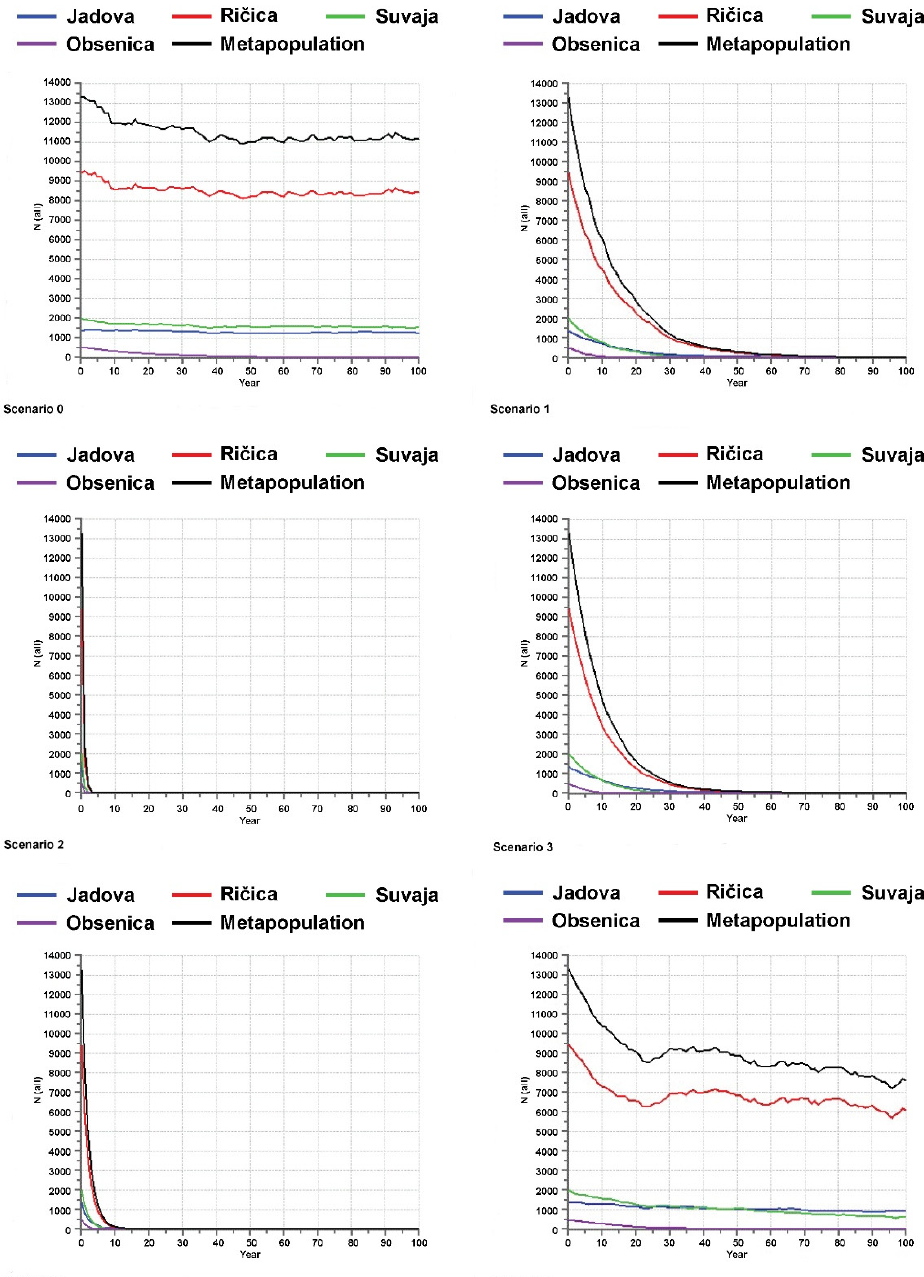
Figure 2. Results of population viability analyses for T. croaticus based on six scenarios.